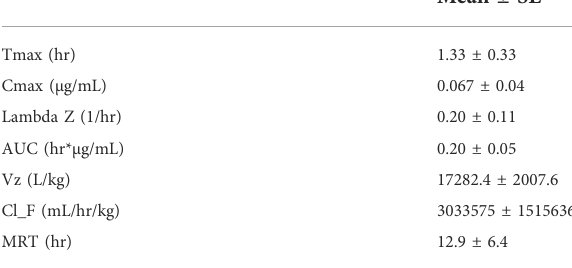
TABLE 4 Pharmacokinetics parameters of pro-EGCG in the plasma of the SD rats ( n = 3) within 24 h after intragastric administration of 50 mg/kg